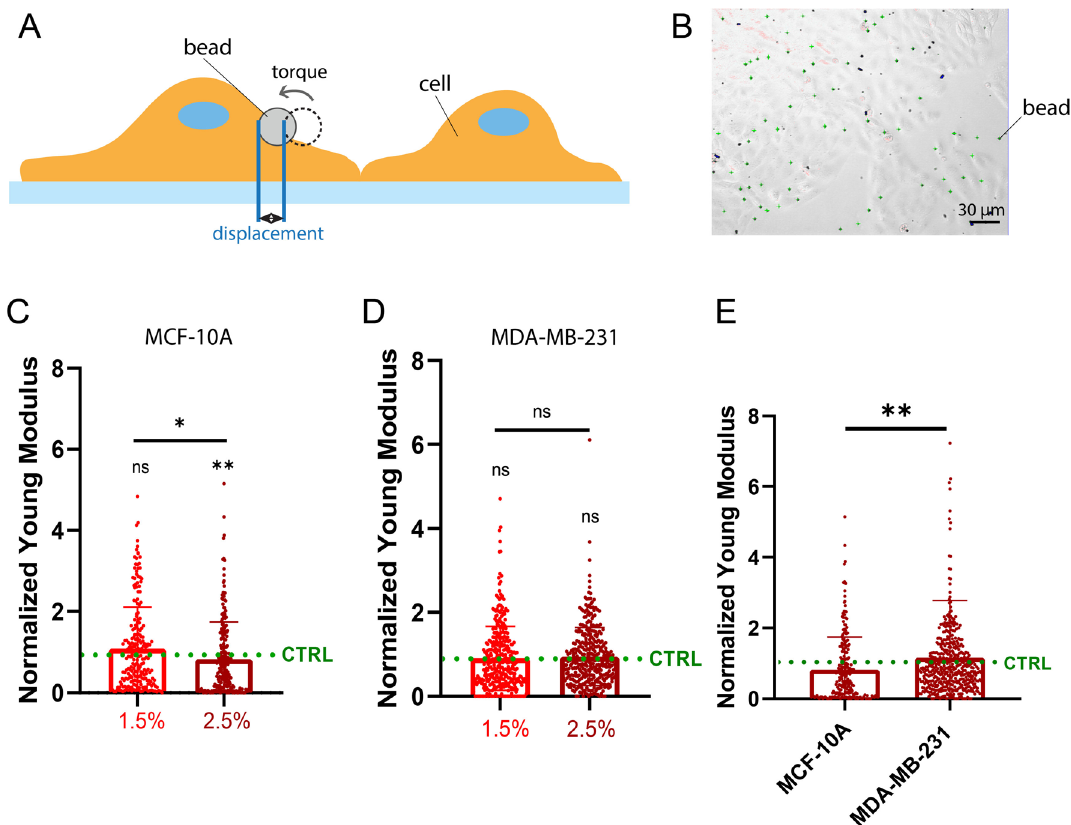
Figure 2. The rigidity of breast cell lines is not affected by osmotic stress. ( A ) Schematic representation of OMTC measurements. ( B ) Typical DIC images of OMTC experiment. Elastic modulus with different concentrations of PEG 1.5% (red) and 2.5% (dark red) normalized by those under isotonic condition for ( C ) MCF-10A and ( D ) MDA-MB-231 cells. ( E ) Comparison of normalized elastic modulus for the two cell lines exposed to 2.5% PEG with 70 ≤ n ≤ 140 for all experiments. *0.01 < p < 0.05, **0.001 < p < 0.01, **** p < 0.0001 and n.s.